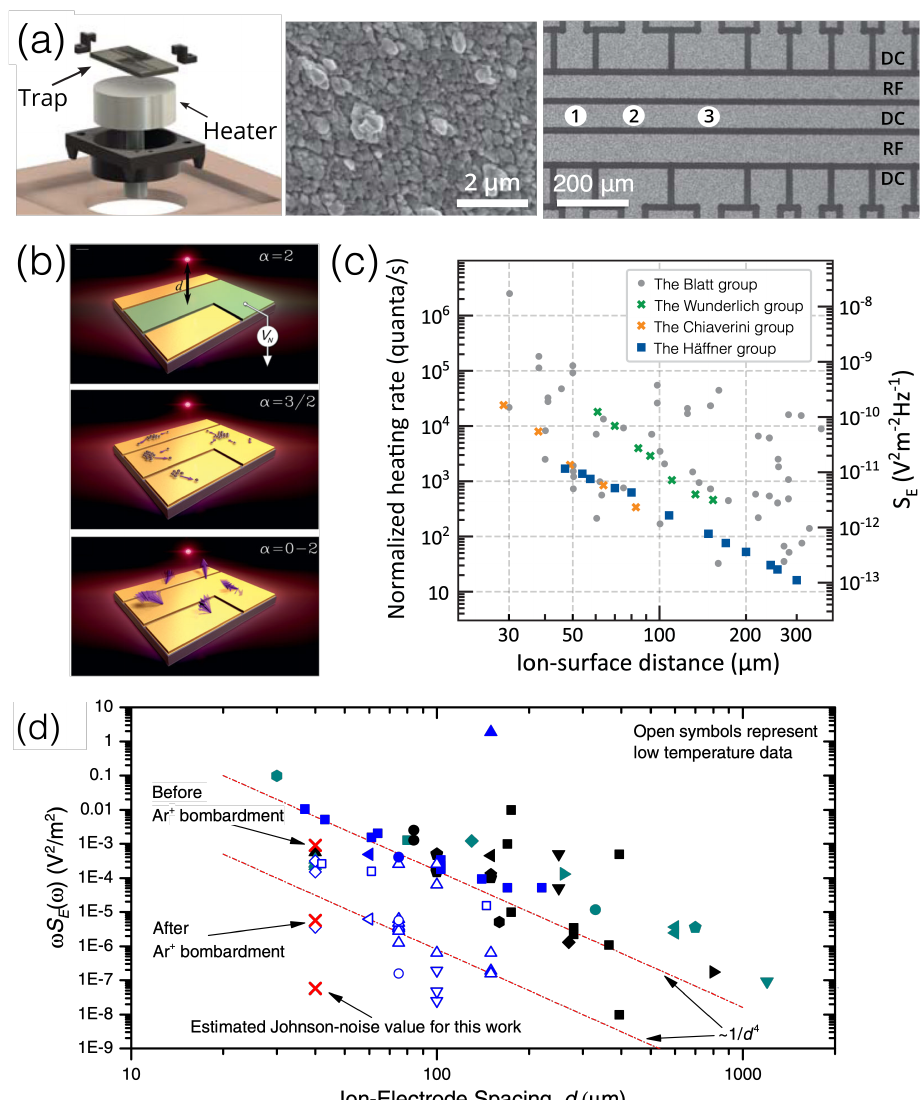
Figure 6. ( a ) A schematic of a surface ion trap with DC and RF electrodes and a scanning electron microscope image of the Al and Cu surface where a Ca + ion is trapped above 72 µ m, reproduced with permission from Ref. [147]; ©2019 American Physical Society. ( b ) Three scenarios of surface noise sources: Johnson noise (top), local work function variations of metals due to adsorbates (middle), and dipole drift (bottom), adapted with permission from Ref. [158]; ©2013 Springer Nature. ( c ) Distance-scaling behavior of heating rates as a function of the ion–surface distance d . Gray circles are for single-ion motional heating, but blue squares follow the d − 2.6 trend, adapted with permission from Ref. [159]; ©2019 American Physical Society. ( d ) In situ argon-ion cleaning to reduce electric field noise. Image is adapted with permission from Ref. [162]; ©2012 American Physical